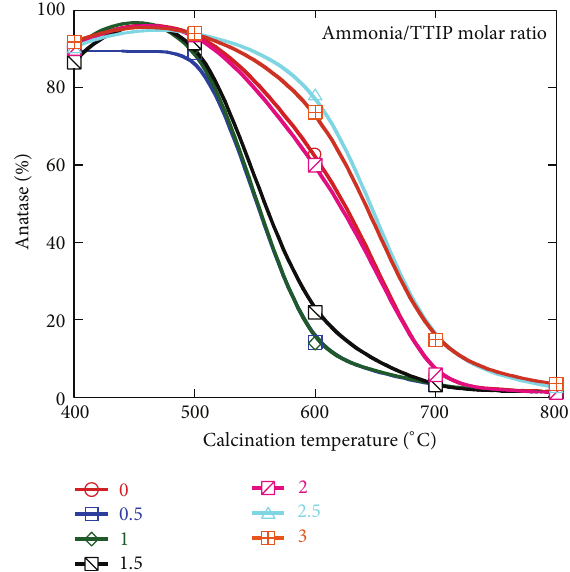
Figure 3: The anatase content of N-TiO 2 samples as a function of the various ammonia/TTIP molar